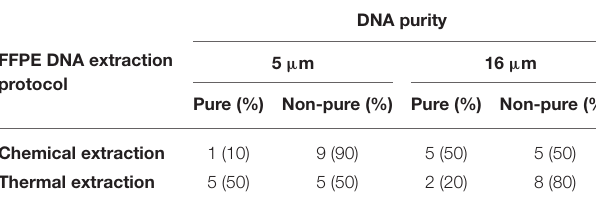
TABLE 2B | Comparison of chemical and thermal DNA extraction protocols in clinical FFPE skin samples from ten cats, using the two paraffin sectioning protocols (5 and 16 µ m), in relation to the degree of DNA purity (A 260 /A 280 nm ratio).